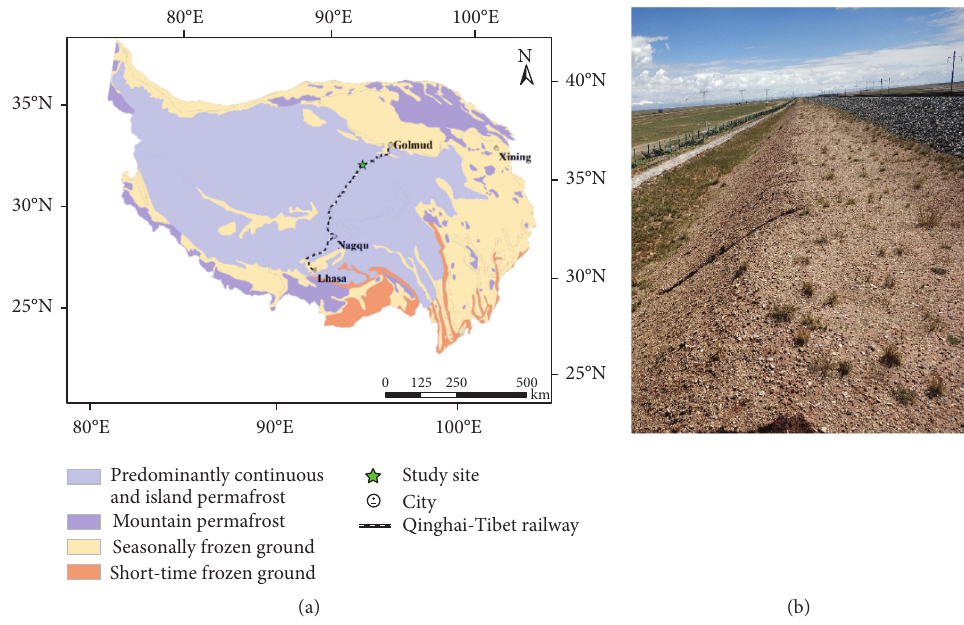
Figure 1: Location (a) and image (b) at section K1068+750.